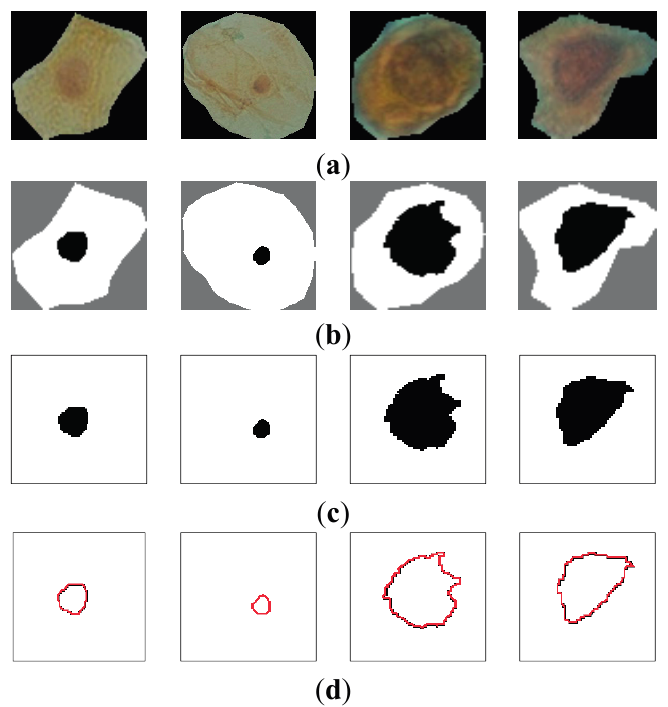
Figure 5. ( a ) raw sputum cells; ( b ) nucleus and cytoplasm segmentation; ( c ) nucleus region; ( d ) the perimeter of the nucleus